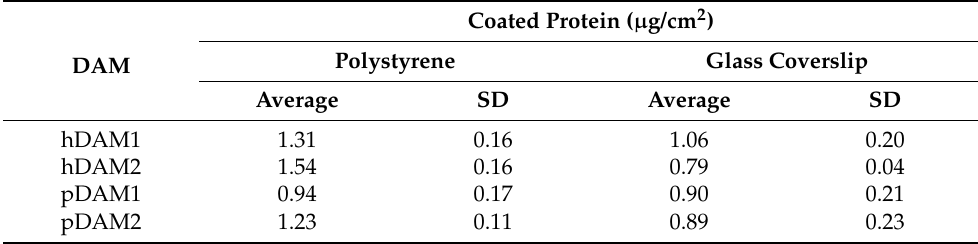
Table 3. Coated total protein on polystyrene and glass coverslip for all the DAMs (hDAM1, pDAM1, hDAM2,